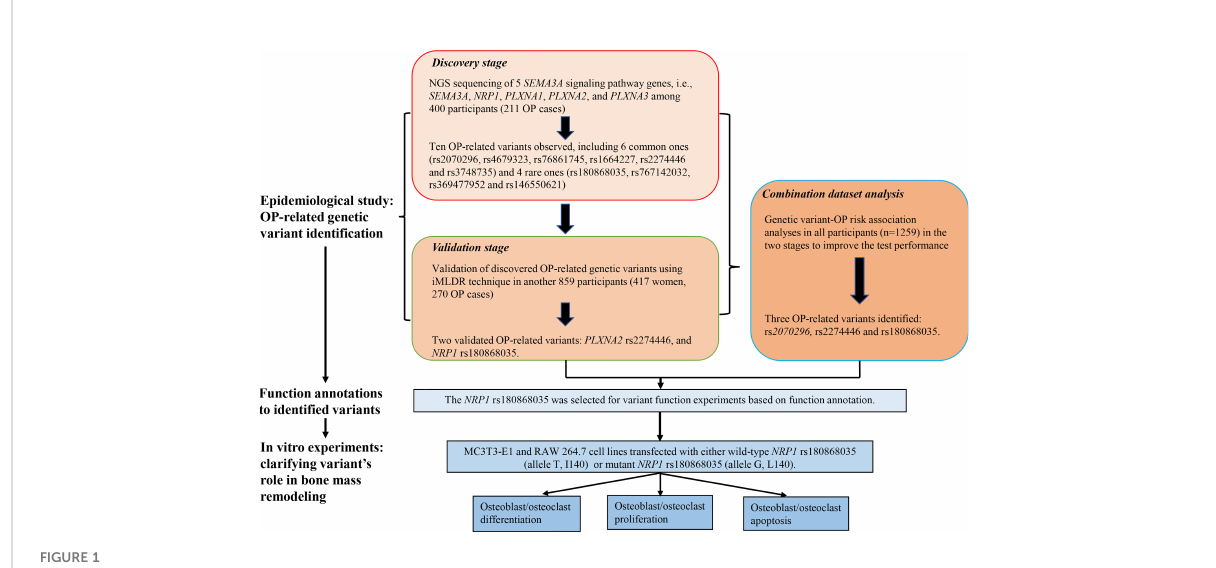
FIGURE 1 Framework of the study